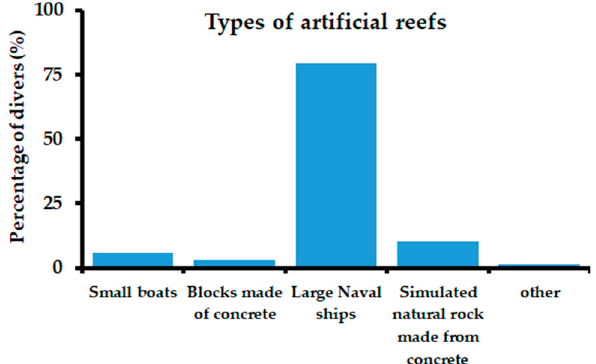
Figure 4. Types of artificial reefs the participants prefer if a new artificial reef is to be developed in the area where they most often